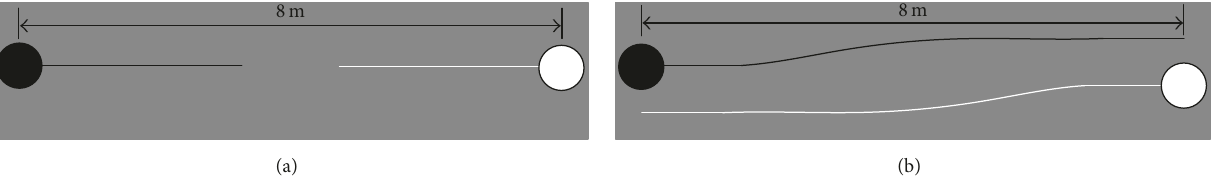
Figure 11: The moving trajectory by the original model. (a) is the “face-to-face” case, where 𝑙 𝑖𝑗 = 0 m, and (b) is the “brush past” case, where 𝑙 = −0.3 m. 𝑖𝑗